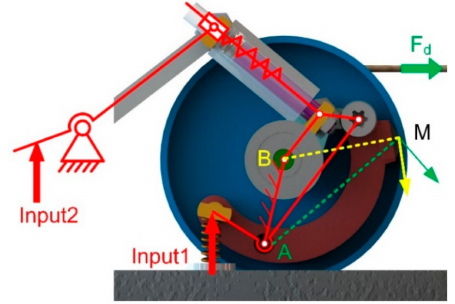
Figure 6. Two-inputs mechanical sensing system. For Input 1, the force is transmitted by a leveling mechanism. For Input 2, the force is transmitted by a four-bar